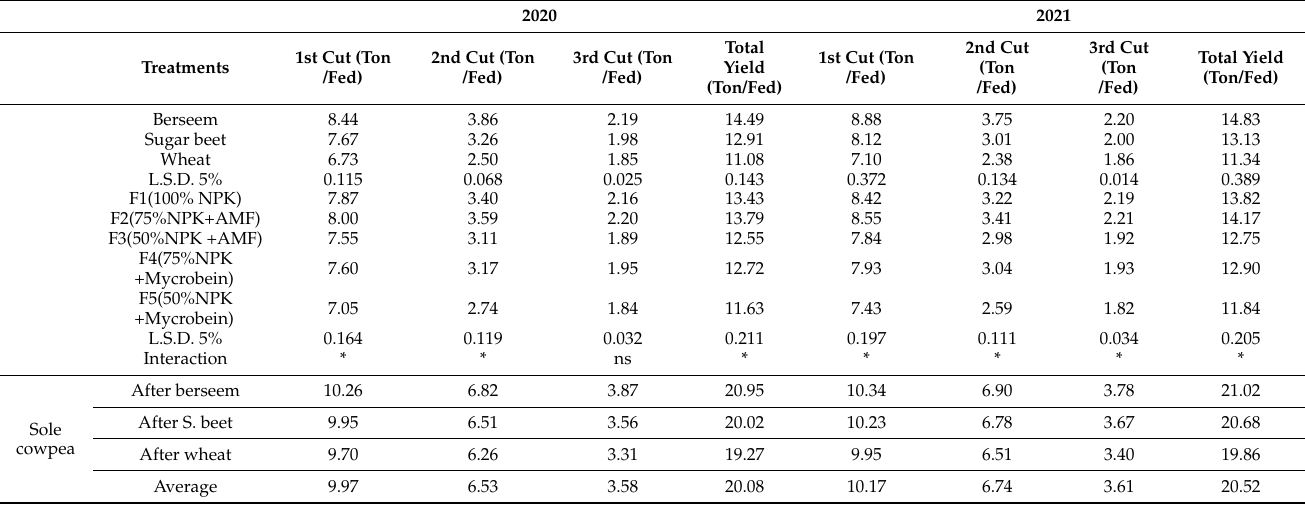
Table 7. The effect of preceding crops and fertilizations on cowpea forage cuts during 2020 and 2021 seasons under intercropping with compared with mono cropping of